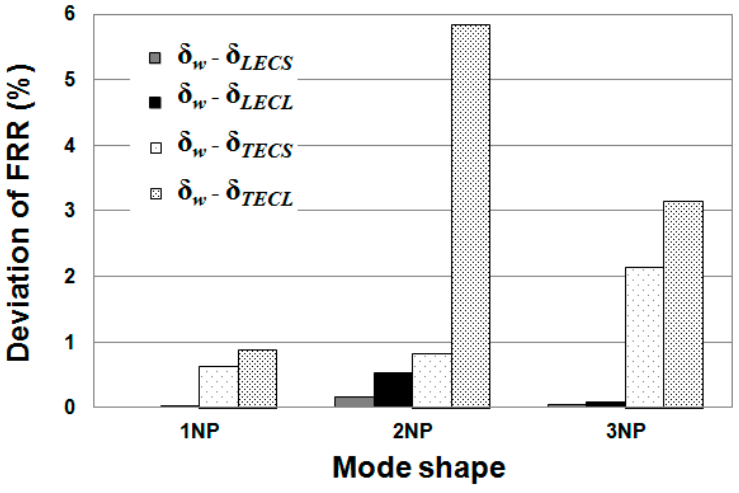
Figure 8. Comparison of the deviation of FRRs for the single blade.